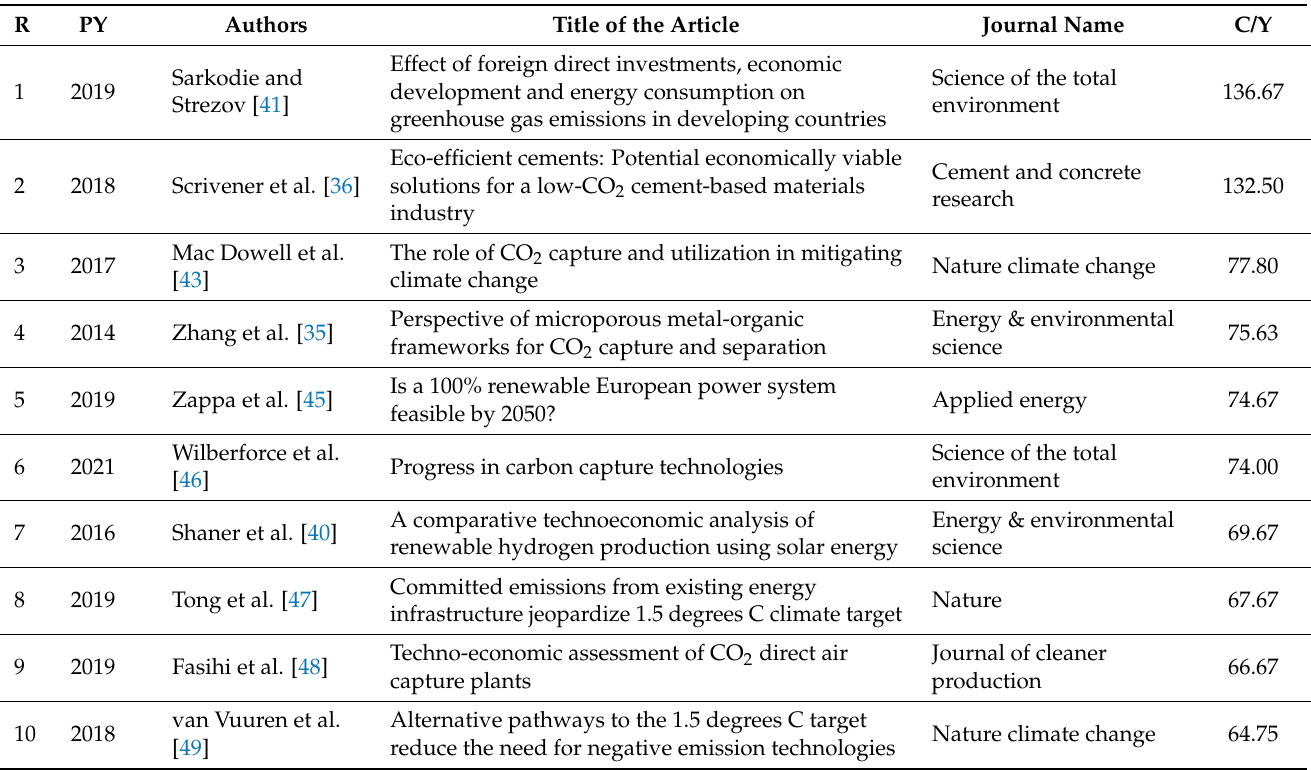
Table 7. Top ten most cited articles in carbon capture and utilization (based on citations per year).